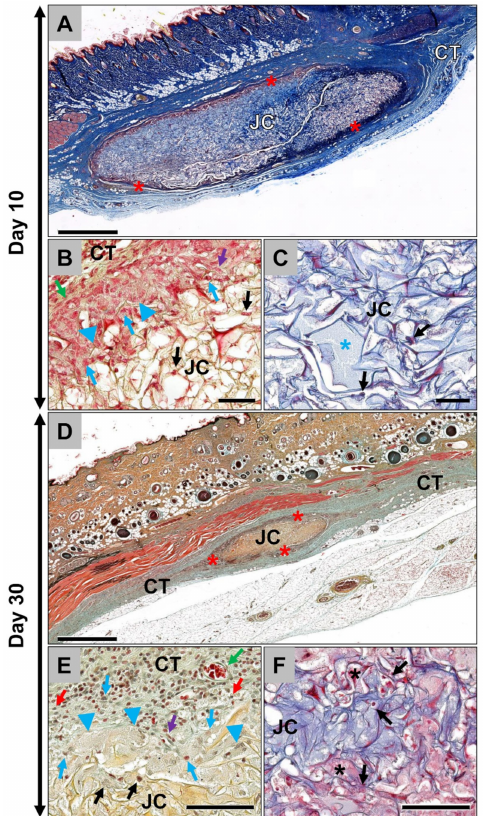
Figure 1. Histological images from the implantation beds of the analyzed jellyfish collagen sca ff olds (JC) within the subcutaneous connective tissue (CT). ( A ) The jellyfish collagen sca ff old (JC) has a distinct oval shape and a visible thin surface cell layer (red asterisks) at 10 days post implantationem (“total scan”, Masson’s Trichrome-staining, 10 × magnification, scale bar = 1mm). ( B ) At the material surface, a layer composed of mononuclear cells that were mainly macrophages (blue arrows) and fibroblasts (purple arrow) as well as some single multinucleated giant cells (blue arrowheads) in direct neighborhood to small blood vessels (green arrow) were observable. Only a few mononuclear cells of the monocyte / macrophage line penetrated the outer regions of the sca ff olds (black arrows) (Movat’s Pentachome-staining, 20 × magnification, scale bar = 50 µ m). ( C ) Only a very small number of mononuclear cells (black arrows), i.e., monocytes / macrophages, were present in the center of the sca ff olds and most of the collagen fiber interspaces were filled with fibrin (blue asterisk) at this early study time point (Masson’s Trichrome-staining, 20 × magnification, scale bar = 50 µ m). ( D ) At day 30, the jellyfish collagen sca ff olds (JC) were still observable within the subcutaneous implantation beds and were significantly reduced. Furthermore, a cell layer (red asterisks) was present at the material surfaces (Movat’s Pentachrome-staining, 10 × magnification, scale bar = 1mm). ( E ) At the sca ff old surface, mainly macrophages (blue arrows) and multinucleated giant cells (blue arrowheads) beside single fibroblasts (purple arrow) and lymphocytes (red arrows) in combination with blood vessels (green arrow) were detectable at this time point. Still, only single mononuclear cells were found within the outer regions of the sca ff olds (black arrows) (Movat’s Pentachome-staining, 20 × magnification, scale bar = 100 µ m). ( F ) At this time point, also single mononuclear cells (black arrows) and provisional matrix (black asterisks) were found within the sca ff old centers (Masson’s Trichrome-staining, 20 × magnification, scale bar = 100 µ